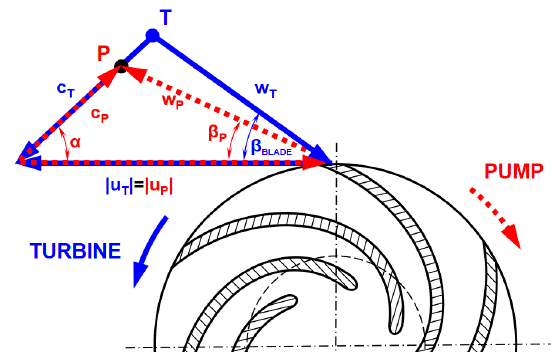
Figure 1. Kinematic conditions during pump and turbine operation.